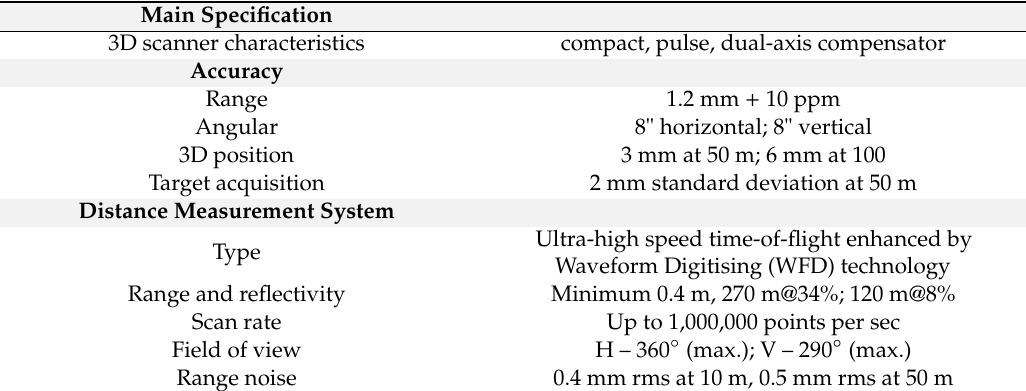
Table 2. Leica P40 3D scanner characteristics.